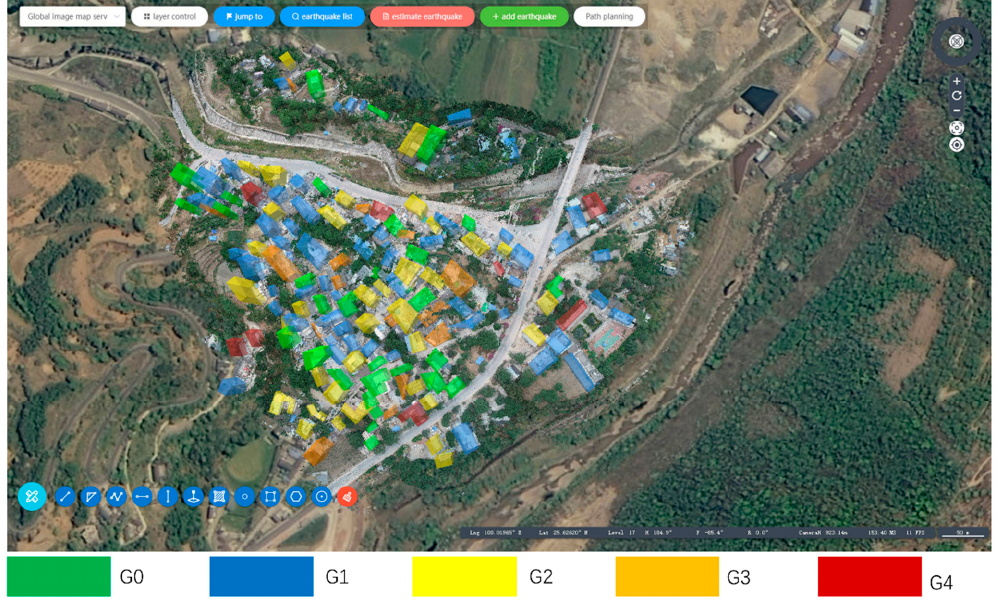
Figure 6. Results of the damaged assessment in Jinniu Village,